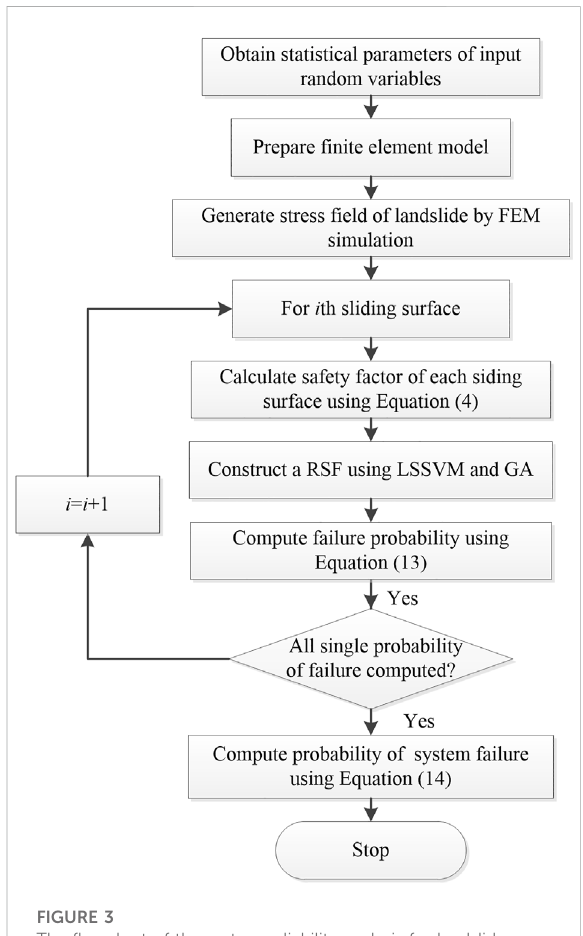
FIGURE 3 The fl owchart of the system reliability analysis for